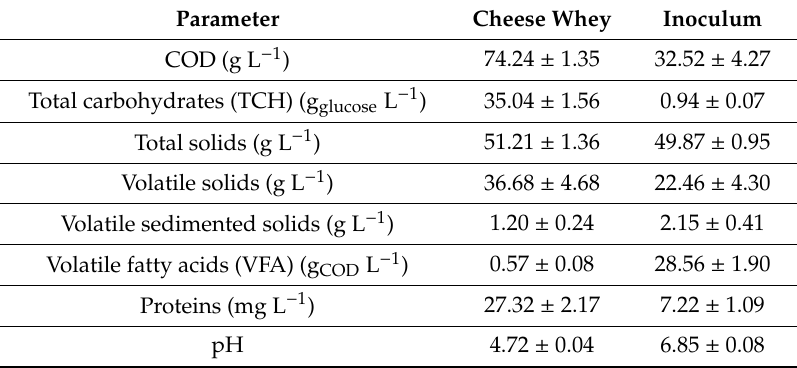
Table 1. Physicochemical characterization of the raw cheese whey and